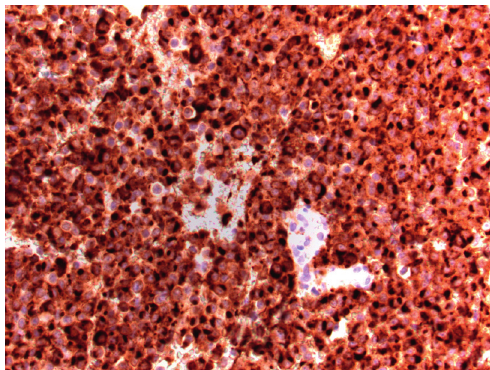
Figure 5: Immunohistochemical stain for prolactin showing prominent granular cytoplasmic staining with perinuclear Golgi pattern accentuation (400x magnification).